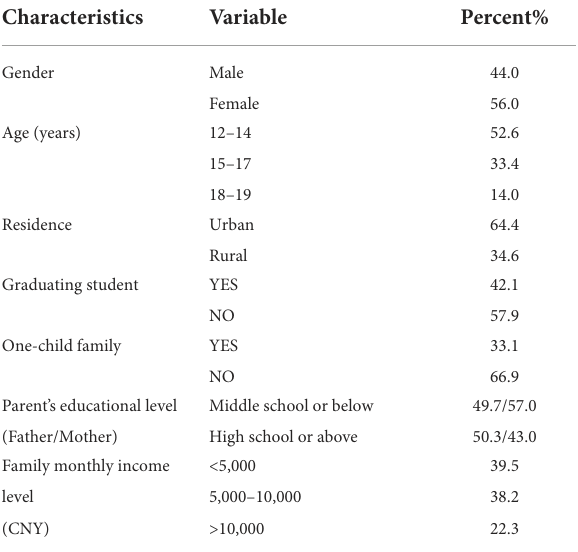
TABLE 2 Sample characteristics ( n =